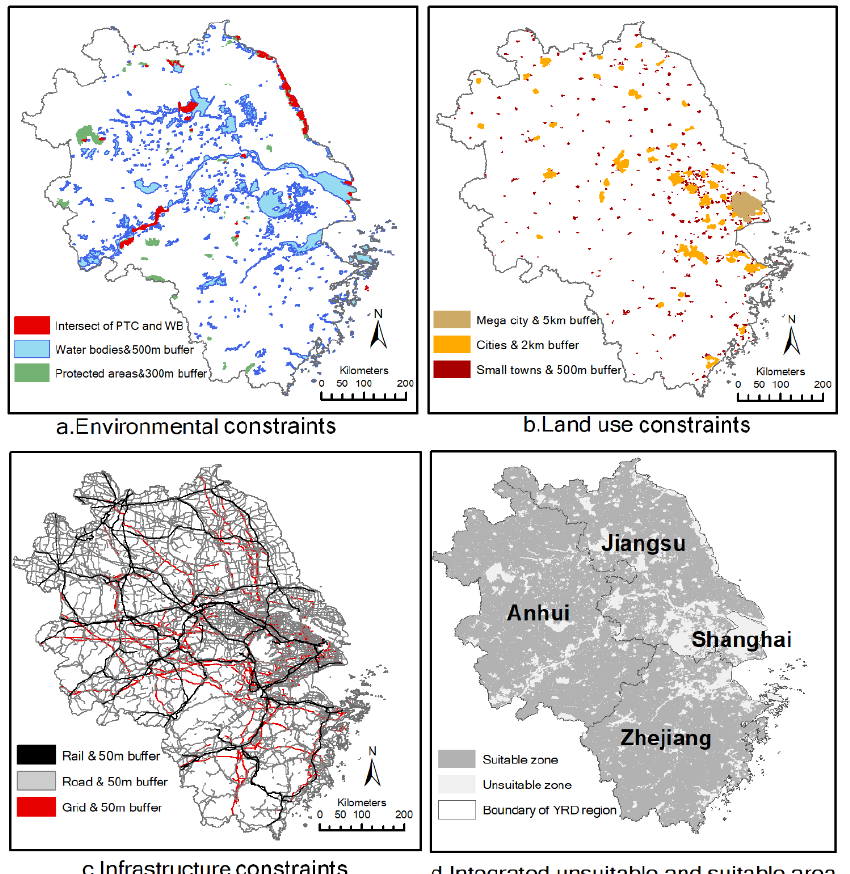
Figure 4. Suitable